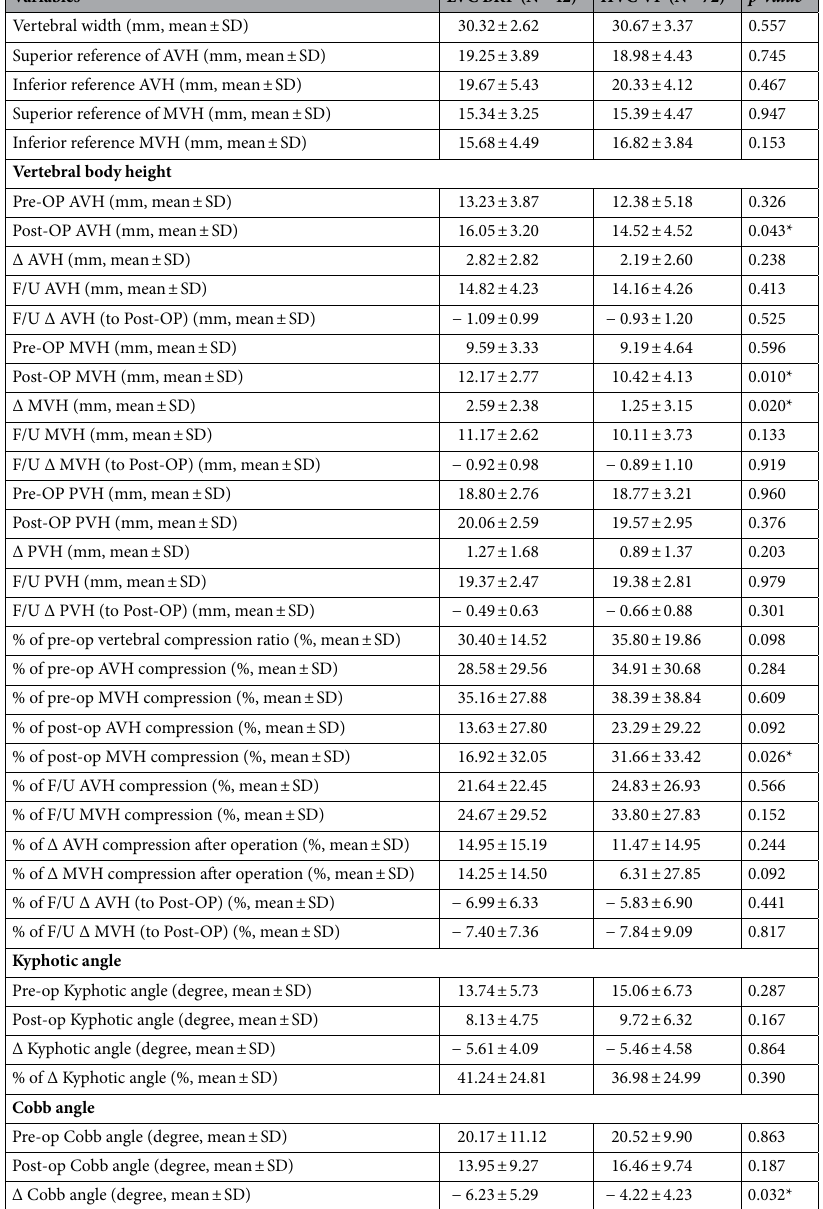
Table 2. Radiographic data between LVC BKP and HVC VP. LVC BKP low-viscosity cement balloon kyphoplasty, HVC VP high-viscosity cement vertebroplasty, N number, mm millimeter, SD standard